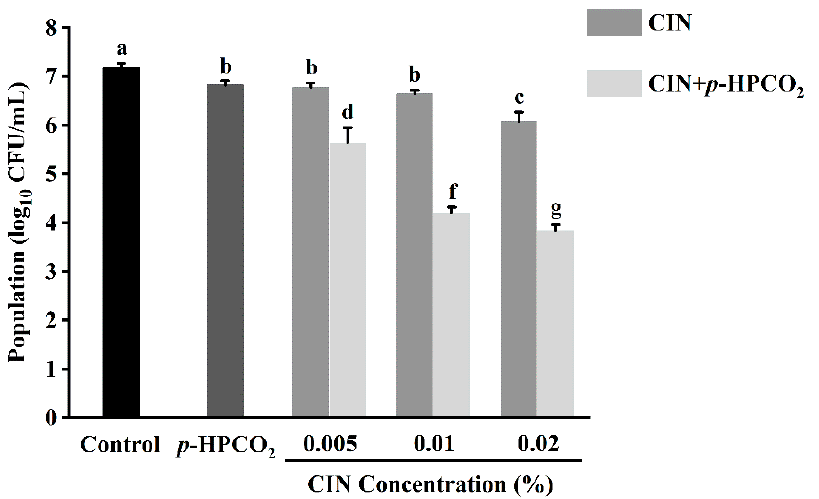
Figure 2. Survival of Saccharomyces cerevisiae after treatment with cinnamon oil (CIN), petit -high pressure CO 2 ( p -HPCO 2 ), and CIN + p -HPCO 2 under 1.3 MPa for 2 h at 25 ◦ C. Different letters above bars mean significant differences ( p <